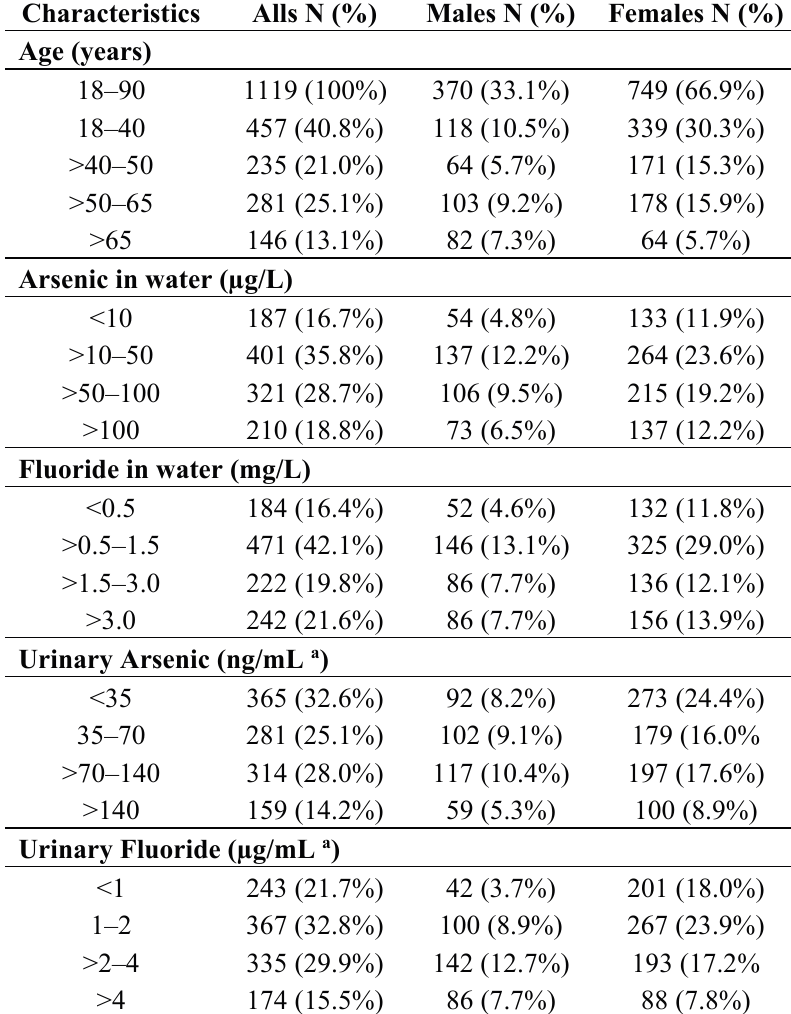
Table 1. Basic characteristics of the Chihuahua study